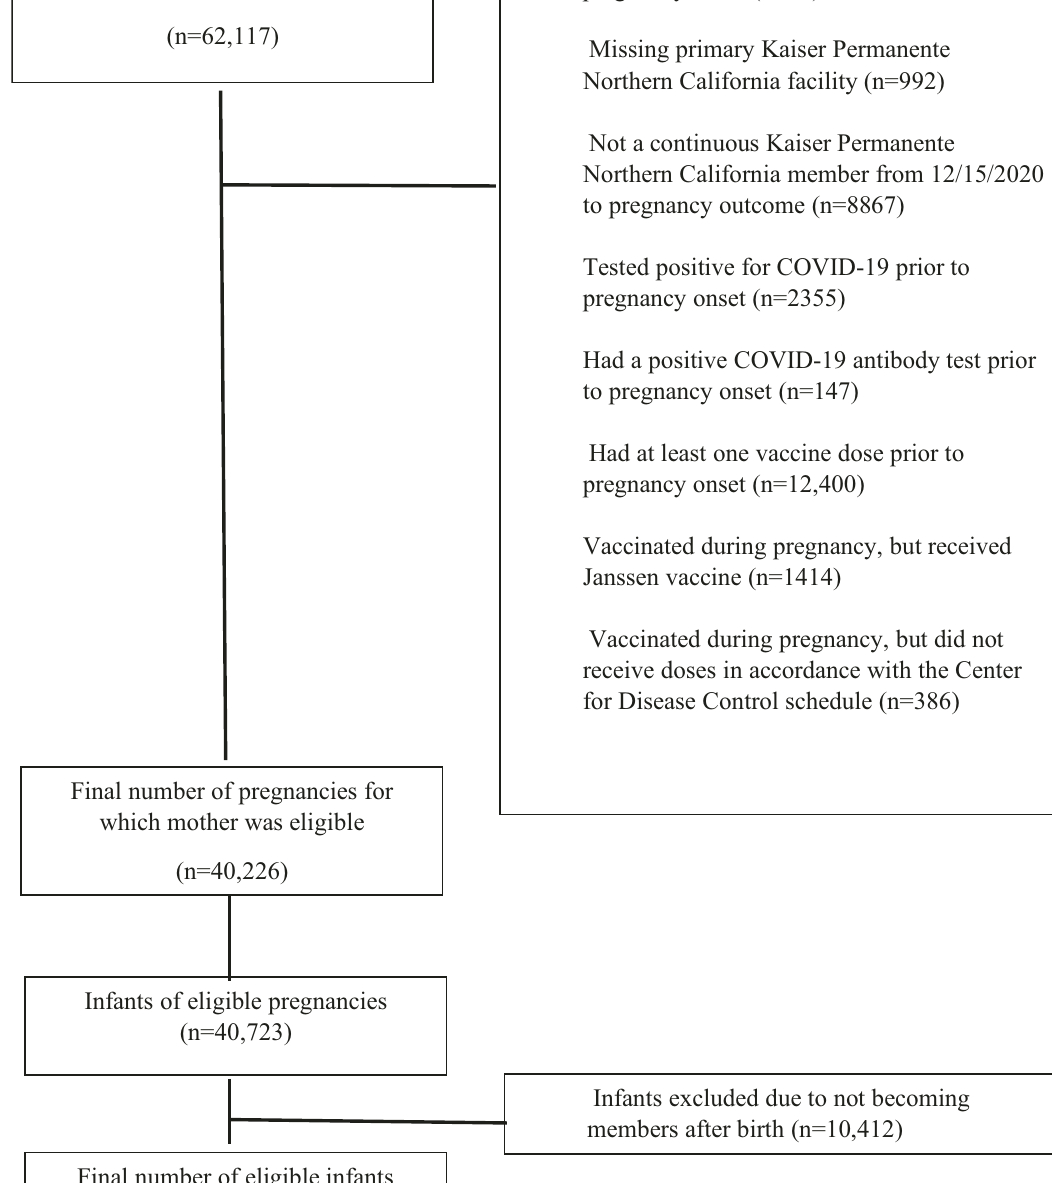
Nature Communications| (2023)